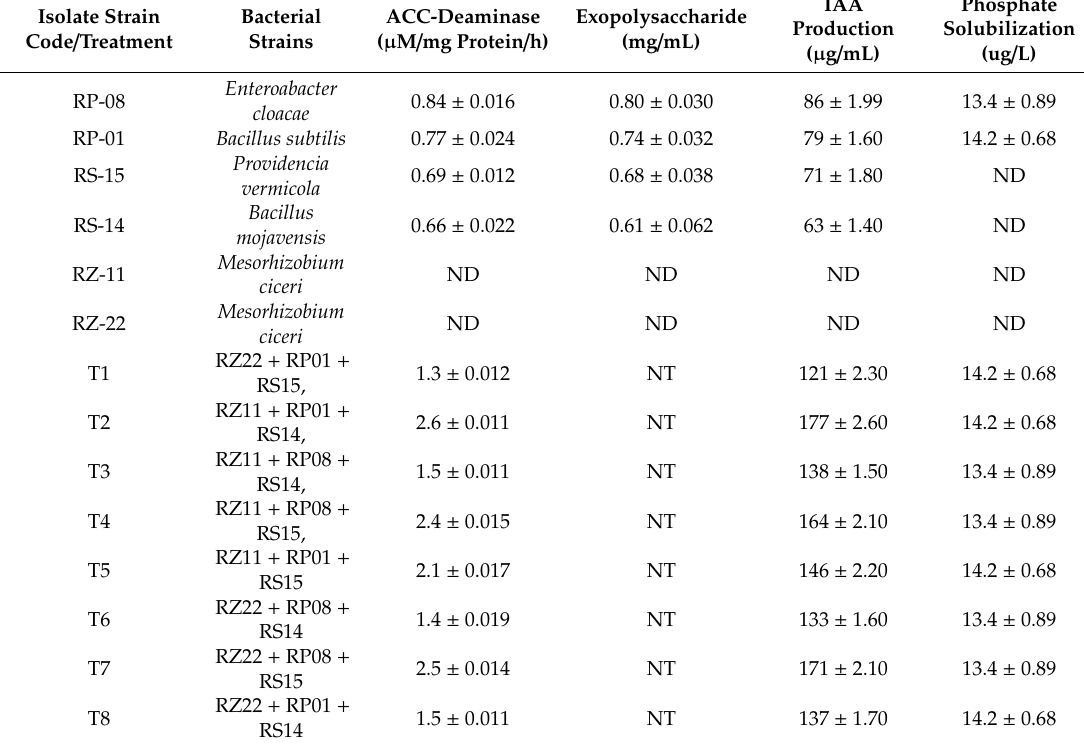
Table 3. Quantitative estimation of EPS and IAA production and ACC-deaminase and Phosphate solubilization activities.